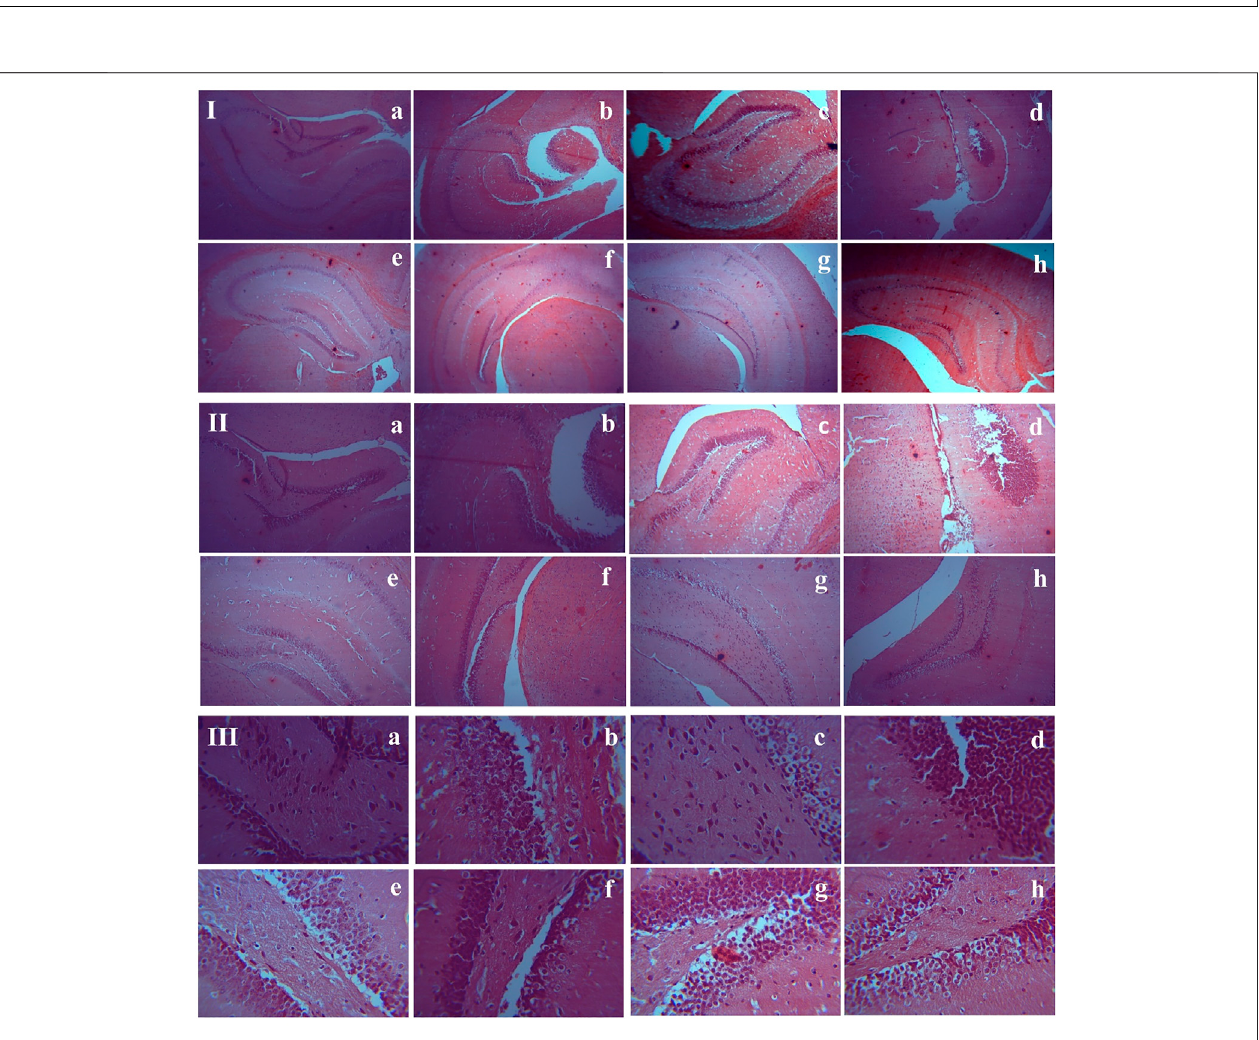
FIGURE 5 | Histological assessment of hippocampal tissues sections stained with Congo Red. (I) 4×, (II) 10×, (III) 40×. (a) Control, (b) Donepezil-treated, (c) MPH-treated, (d) R. of fi cinalis -treated, (e) AlCl 3 -treated, (f) AlCl 3 + Donepezil-treated, (g) AlCl 3 + MPH-treated (h) AlCl 3 + R. of fi cinalis -treated.